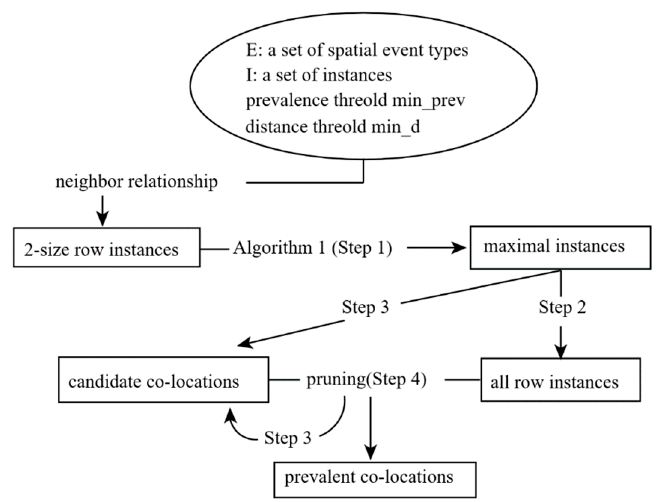
Figure 4. The flow of the maximal instance algorithm.